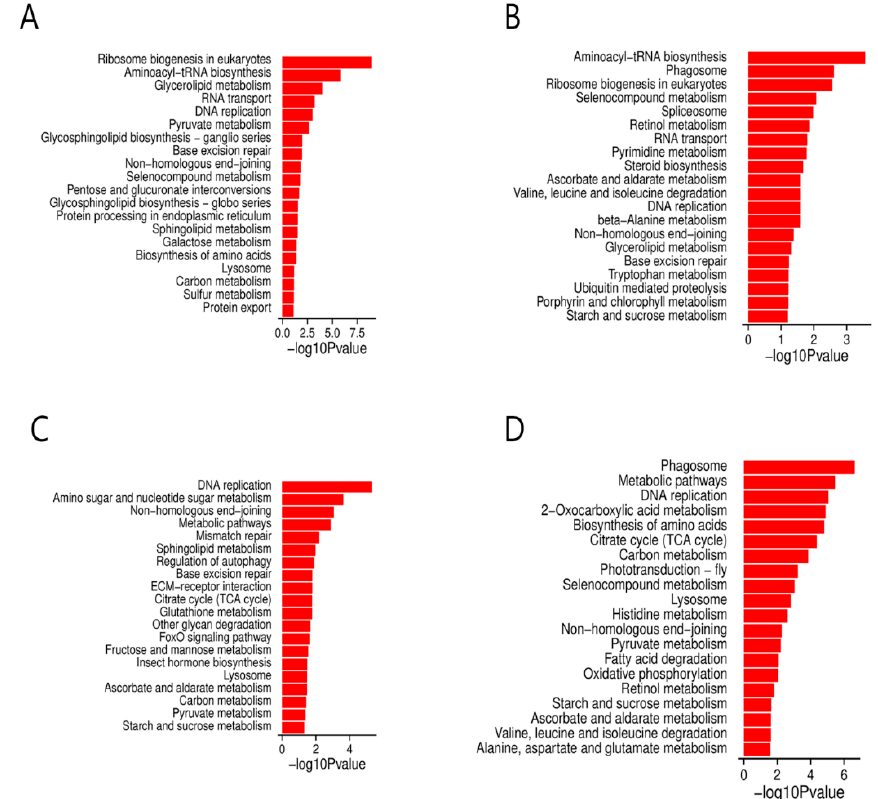
Figure 4. KEGG pathway enrichment analysis of the DEGs. ( A ) KEGG pathway enrichment analysis of the DEGs in B-1h. ( B ) KEGG pathway enrichment analysis of the DEGs in BN-1h. ( C ) KEGG pathway enrichment analysis of the DEGs in B-3h. ( D ) KEGG pathway enrichment analysis of the DEGs in BN-3h.